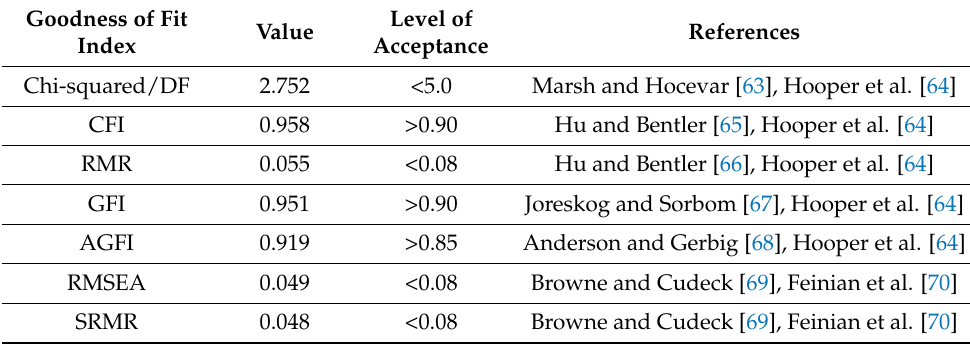
Table 3. The model fit indices and their acceptable thresholds.